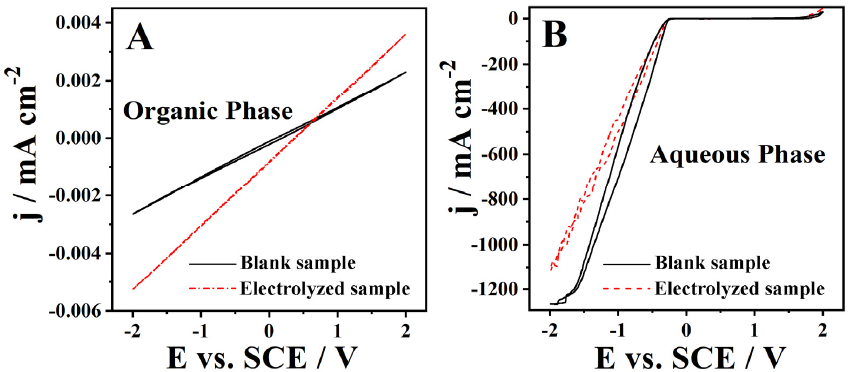
Figure 6. CVs run with a Pt electrode at 50 mV s − 1 of ( A ) the organic phase and ( B ) of the aqueous phase of the cork bio-oil acidic emulsion blank and subjected to 24 h bulk electrolysis (Electrolysis II).